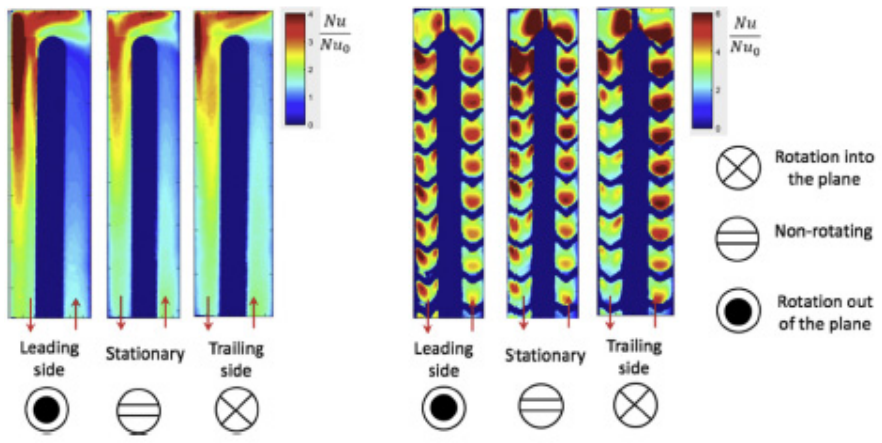
Figure 7. Smooth and ribbed channel heat transfer map under stationary and rotating conditions. Reprinted with permission: License number 5177110161442.